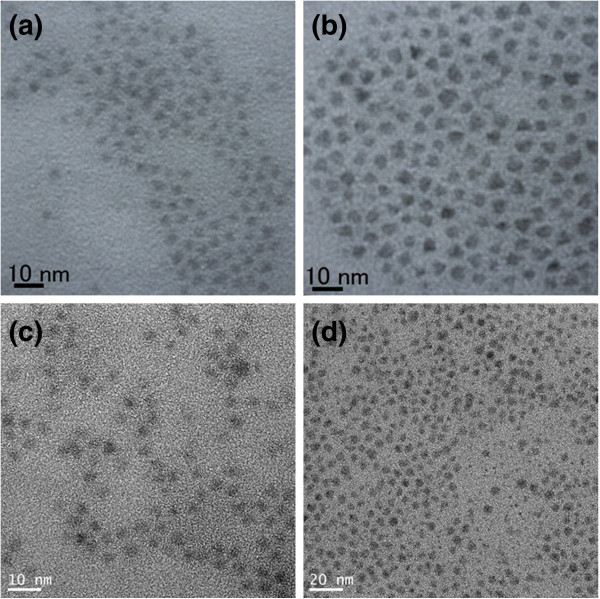
TEM images of CdTe0.5Se0.5cores and CdTe0.5Se0.5/Cd0.5Zn0.5S core/shell QDs shown in Table2. (a) Sample 1 (CdTe0.5Se0.5 cores), (b) sample 2 (CdTe0.5Se0.5/Cd0.5Zn0.5S) prepared by sample 1, (c) sample 3 (CdTe0.5Se0.5), and (d) sample 4 (CdTe0.5Se0.5/Cd0.5Zn0.5S) prepared by sample 3.